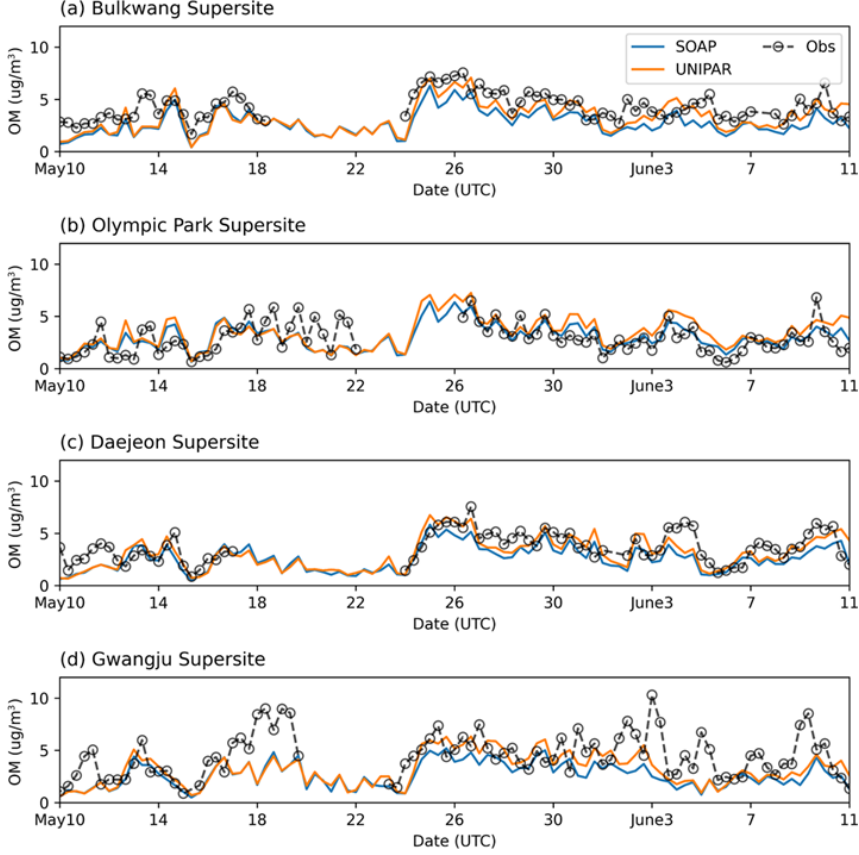
Figure 3. Time profiles of OM concentration (µgm − 3 ) averaged over 8h for the observation data and the CAMx simulation results at the (a) Bulkwang, (b) Olympic Park, (c) Daejeon, and (d) Gwangju supersites.